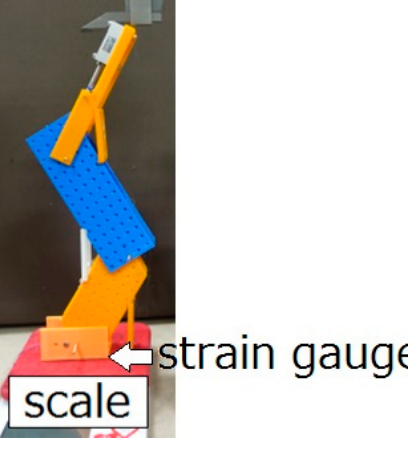
Figure 5. Experimental setup.